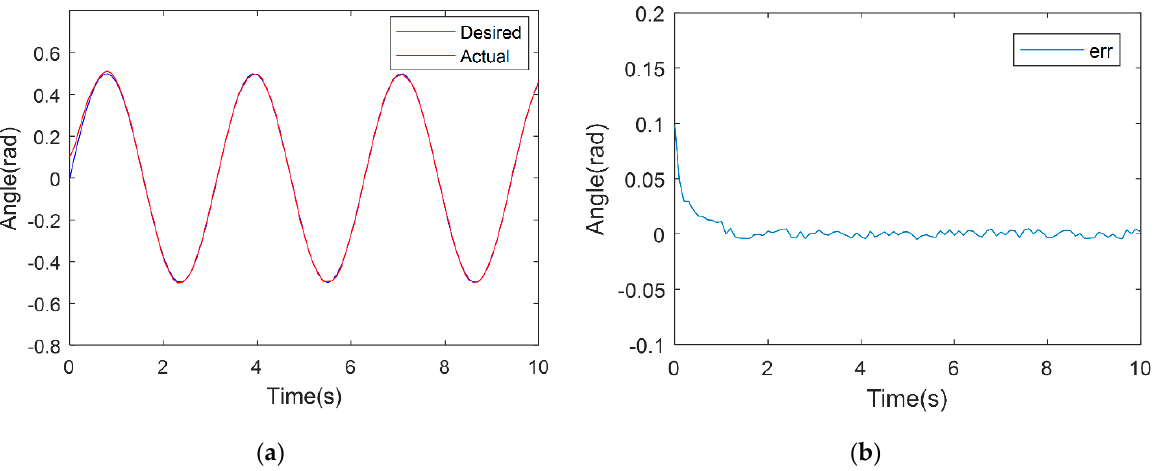
Figure 5. PD-based controller experimental result. ( a ) PD sinusoidal trajectory-tracking experiment results. ( b ) PD sinusoidal tracking experimental errors.